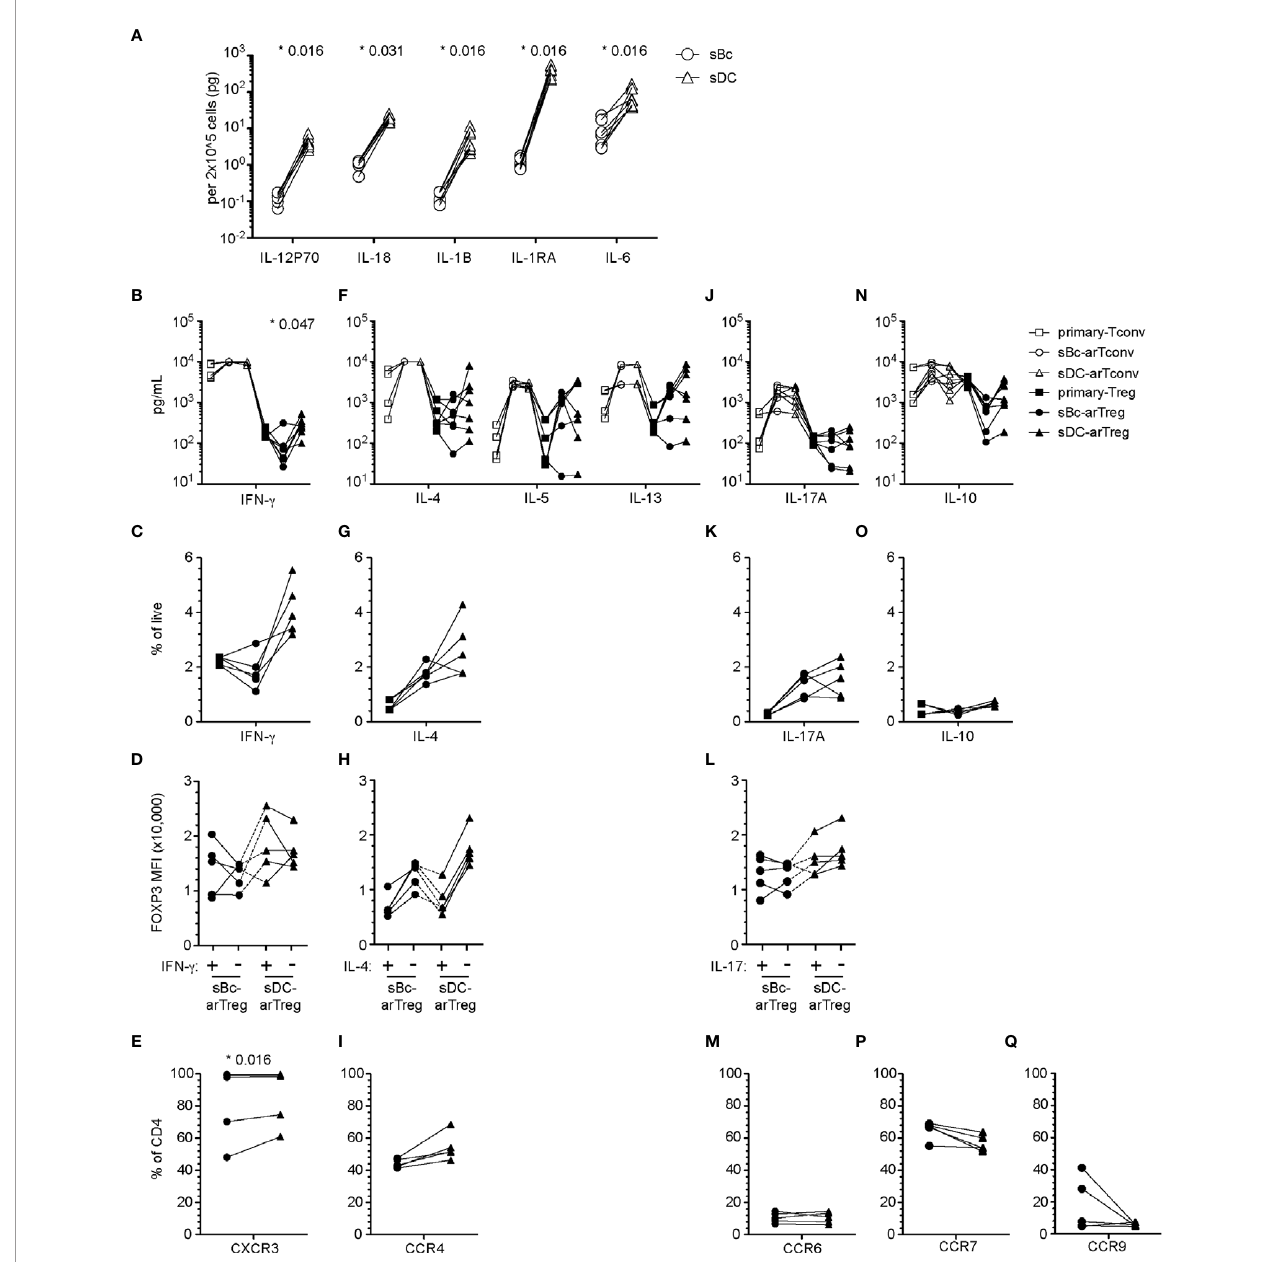
FIGURE 5 | sBc- and sDC-arTregs acquire specialized characteristics while maintaining expression of FOXP3. (A) Secretion of cytokines by sBcs and sDCs. sBcs and sDCs were plated alone at the same density used to culture puri fi ed T cells (200,000 sBcs or 12,500 sDCs in 100µL assay medium). After 48 h, the culture supernatants were harvested and tested for the indicated molecules using Luminex assay. (B, F, J, N) Primary T cells and cultured alloreactive T cells were stimulated with anti-CD3/CD28 beads for 24 h. Supernatants from stimulated cells were collected and analyzed for different cytokines using Luminex assay. (C, D, G, H, K, L, O) Primary T cells and cultured alloreactive T cells were stimulated with PMA/Ionomycin in the presence of Brefeldin A and monensin for 5 h. Cytokine production by arTregs (C, G, K, O) , and level of expression (MFI) of FOXP3 in cytokine- and non-cytokine-producing arTregs (D, H, L) was assessed by intracellular staining. (E, I, M, P, Q) Chemokine receptor expression on arTregs. Data in (A) contain 7 different sBc and sDC pairs. Connecting lines indicate sBcs and sDCs derived from the same donor. Data in (B, F, J, N) contain 7 different responder:stimulator pairs. Data in (C, D, G, H, K, L, O) contain 5 different responder:stimulator pairs. Data in (E, I, M, P, Q) contain at least 5 different responder:stimulator pairs. Connecting lines indicate alloreactive T cells stimulated by APCs (sBcs or sDCs) derived from the same donor. Statistics in (A) were performed using the Wilcoxon matched-pairs signed test. Statistics in (B, C, E, F, G, I, J, K, M, N, O, P, Q) were performed comparing sBc- and sDC-arTreg populations using the Wilcoxon matched-pairs signed rank test. Data from primary Tconvs and arTconvs are shown as a reference and were not included in statistical analyses. Statistics in (D, H, L) were performed compared cytokine-producing and non- producing cells within the same APC stimulation group using the Wilcoxon matched-pairs signed rank